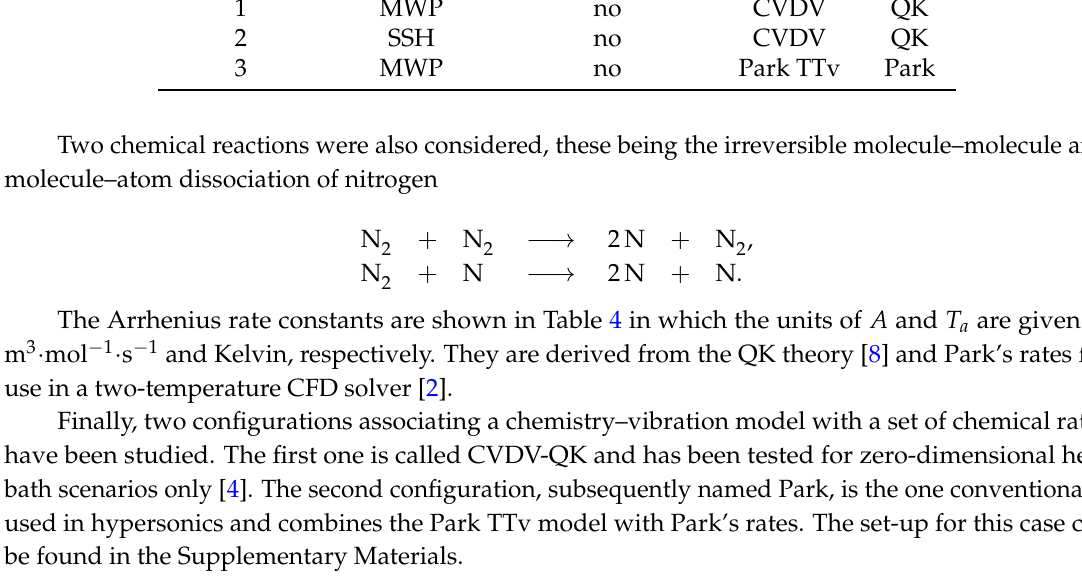
Table 4. Parameters for the evaluation of the forward rate